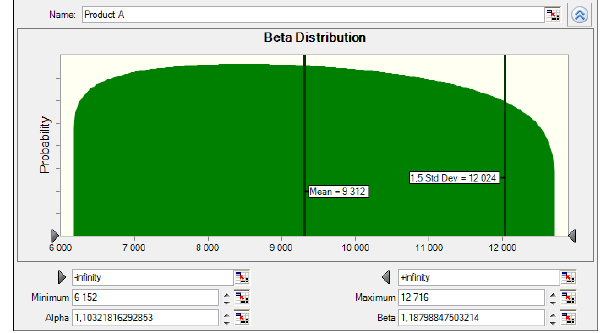
Figure 5: Distribution function for sale of product A.